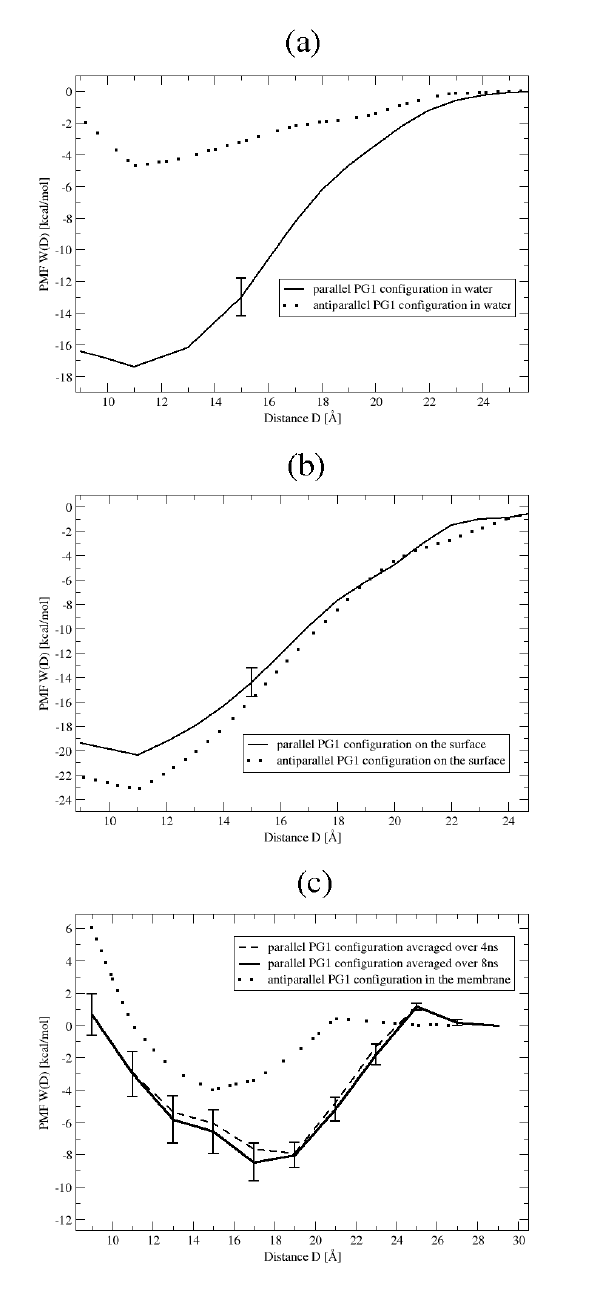
Figure 3. The potential of mean force, W(D), as a function of the distance between two peptides for the PG1 dimer in parallel (solid line) and antiparallel (dottet line) β -sheet arrangements in (a) water, (b) on the membrane surface. Each data point for W(D) represents the mean of eight 0.5 ns simulations. The PMF for the parallel and antiparallel arrangements inside the membrane (c) are also shown. For untiparallel structure (dotted line) each data point for W(D) represents the mean of eight 0.5 ns simulations. For parralel structure we have two plots. The dashed line represents the mean of eight 0.5 ns simulations, whereas solid line represents the mean of sixteen 0.5 ns simulations.